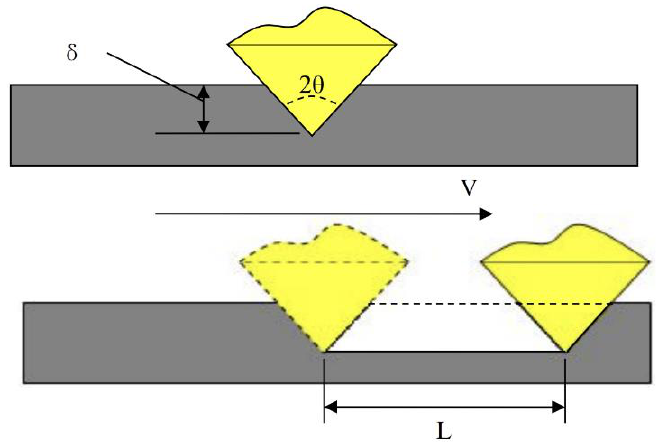
Figure 12. TEM images of a single black spot.